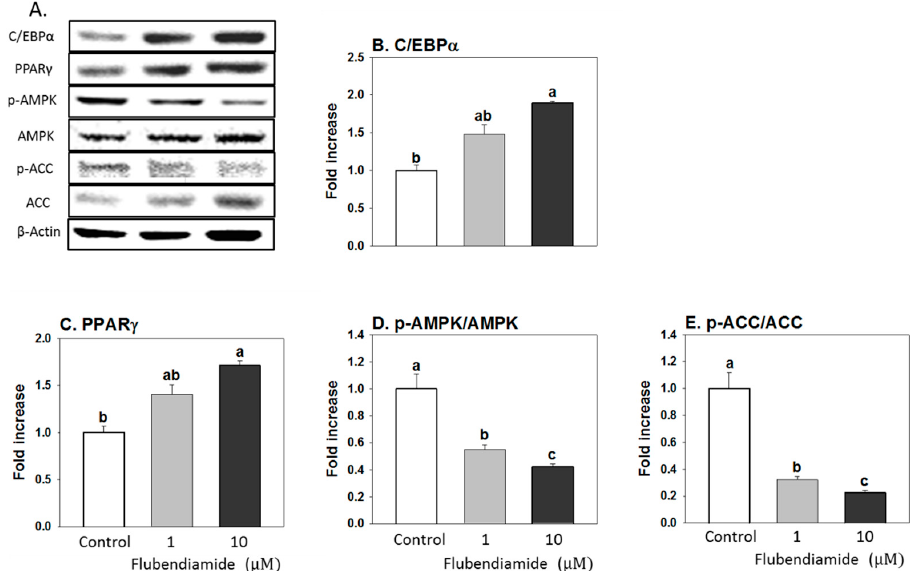
Figure 2. Effects of flubendiamide on protein levels of molecular mediators of adipogenesis. ( A ) representative picture; ( B ) C/EBP- α , CAATT element binding protein- α ; ( C ) PPAR- γ , peroxisome proliferator-activated receptor- γ ; ( D ) pAMPK α /AMPK α , AMP-activated protein kinase- α (inactive form)/phosphorylated AMPK α (active form), ( E ) pACC/ACC, acetyl-CoA carboxylase (active